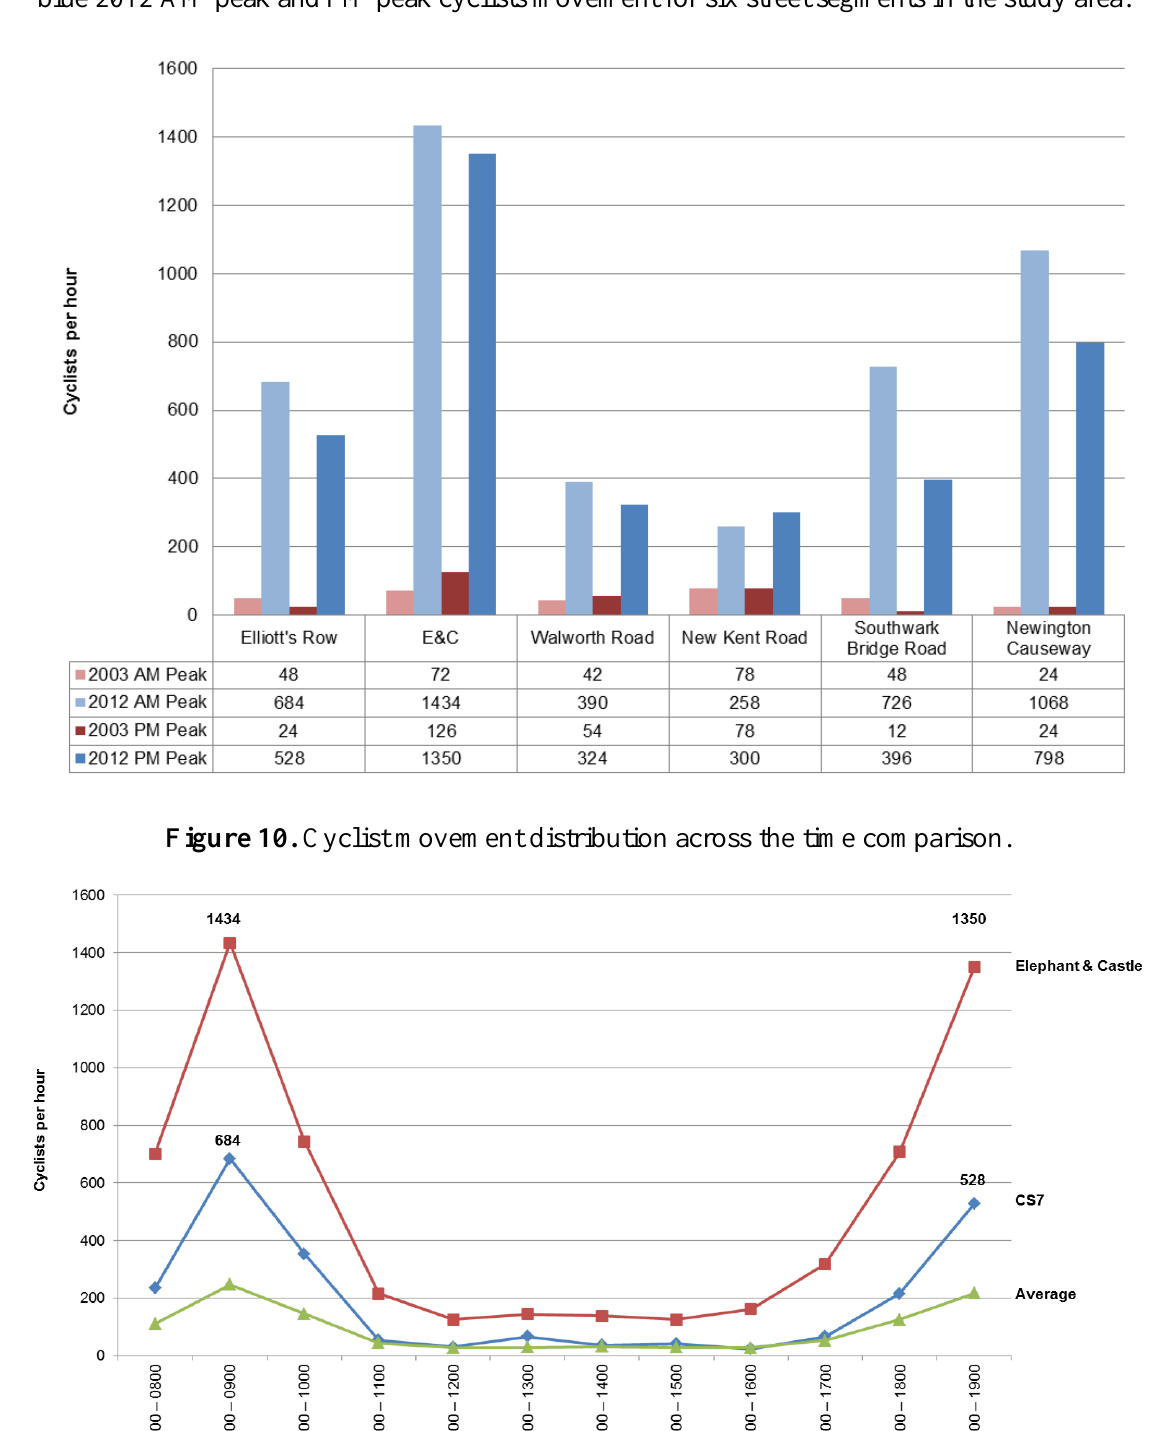
Figure 9. Bar Chart shows in red 2003 AM peak and PM peak cyclists movement and in blue 2012 AM peak and PM peak cyclists movement for six street segments in the study area.